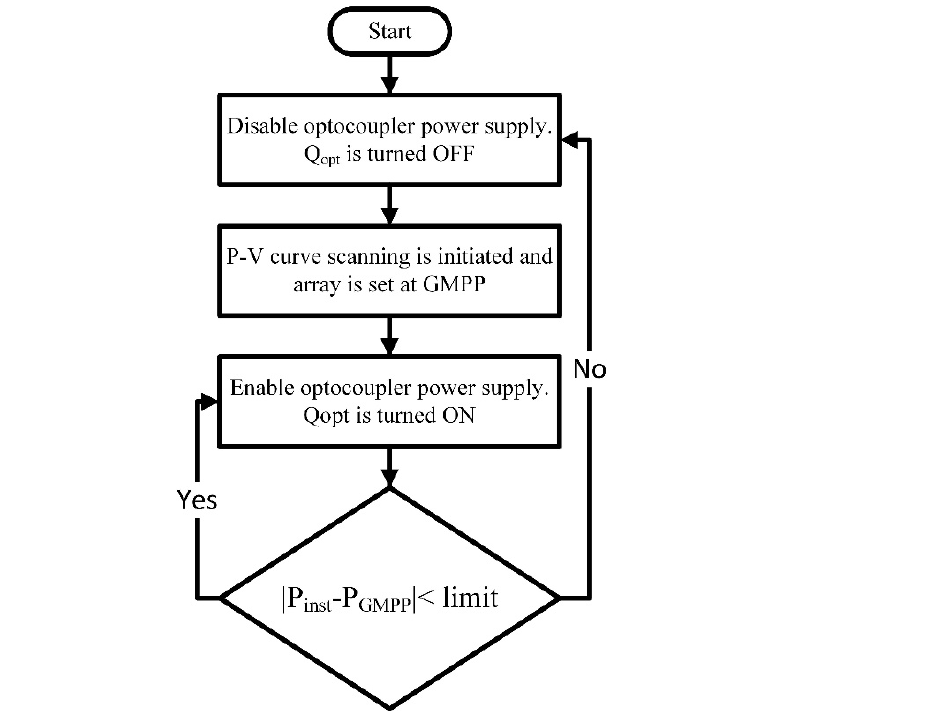
Figure 6. Control technique for complete operation with global MPPT tracking .